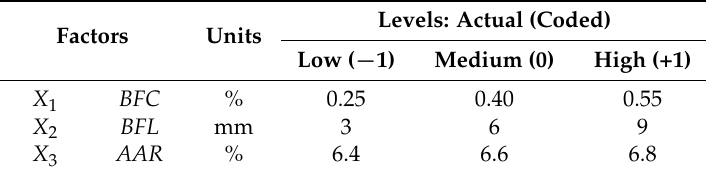
Table 4. Experimental design for face-centered central composite design (FCCD). Levels: Actual Factors Units